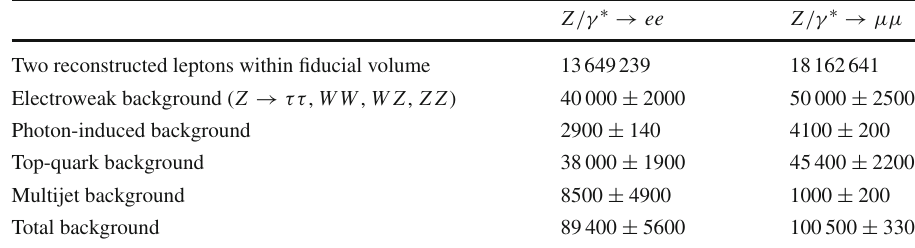
Table 1 Selected signal candidate events in data for both decay channels as well as the expected background contributions including their total